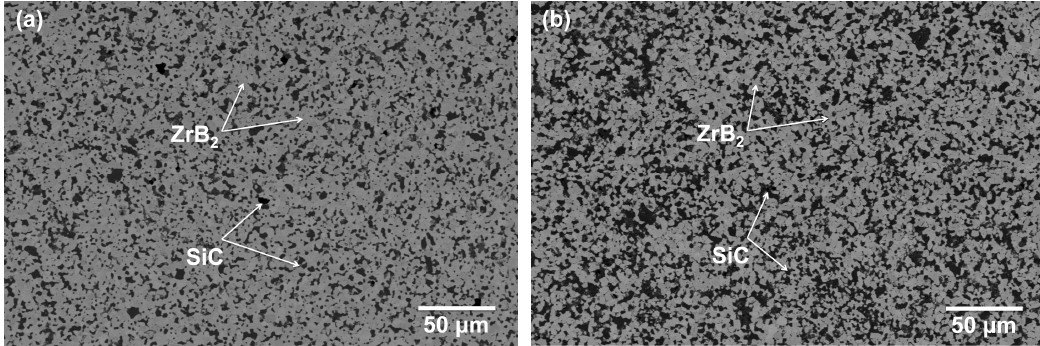
Figure 1. SEM images depicting the microstructures of ( a ) ZS and ( b ) ZSS. Table 1. Room temperature mechanical properties of ZS and ZSS.